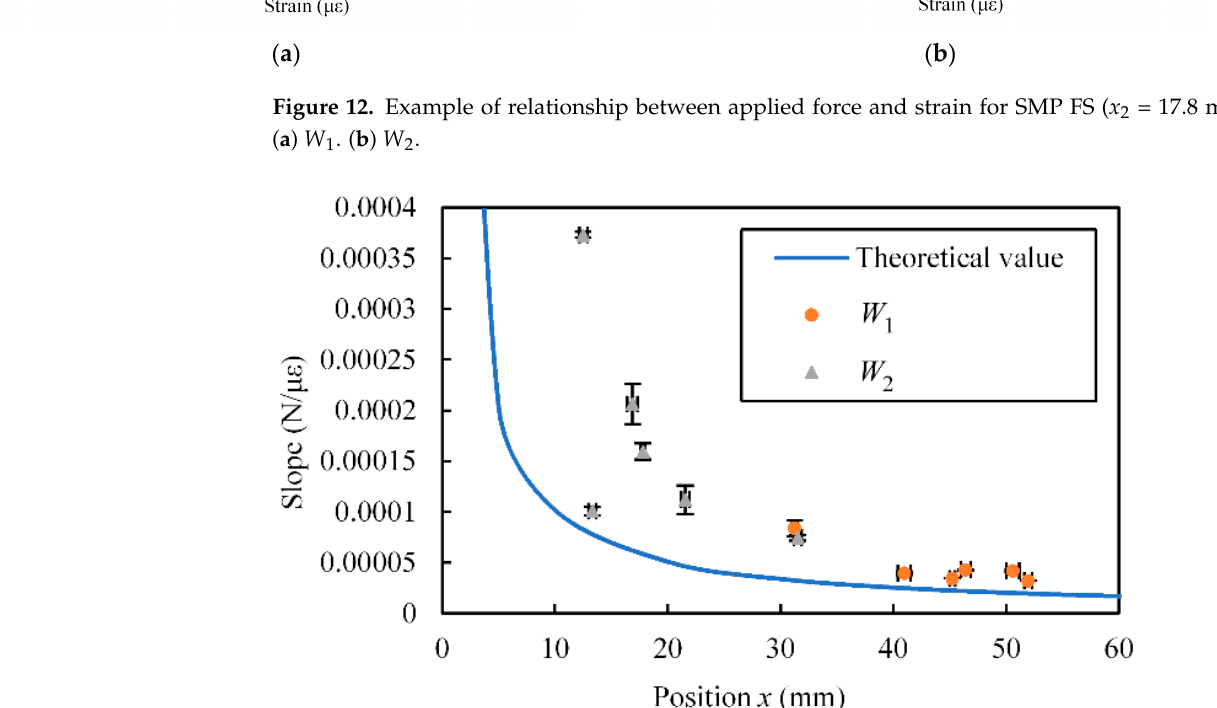
Figure 14. Jig used to bend and heat FS.